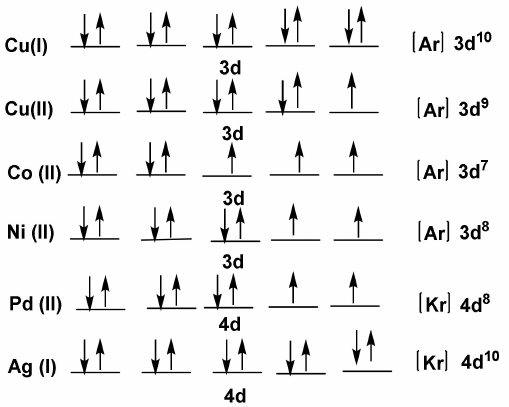
Figure 1. Electronic configurations of Cu(I), Co(II), Ni(II), Pd(II) and Ag (I).